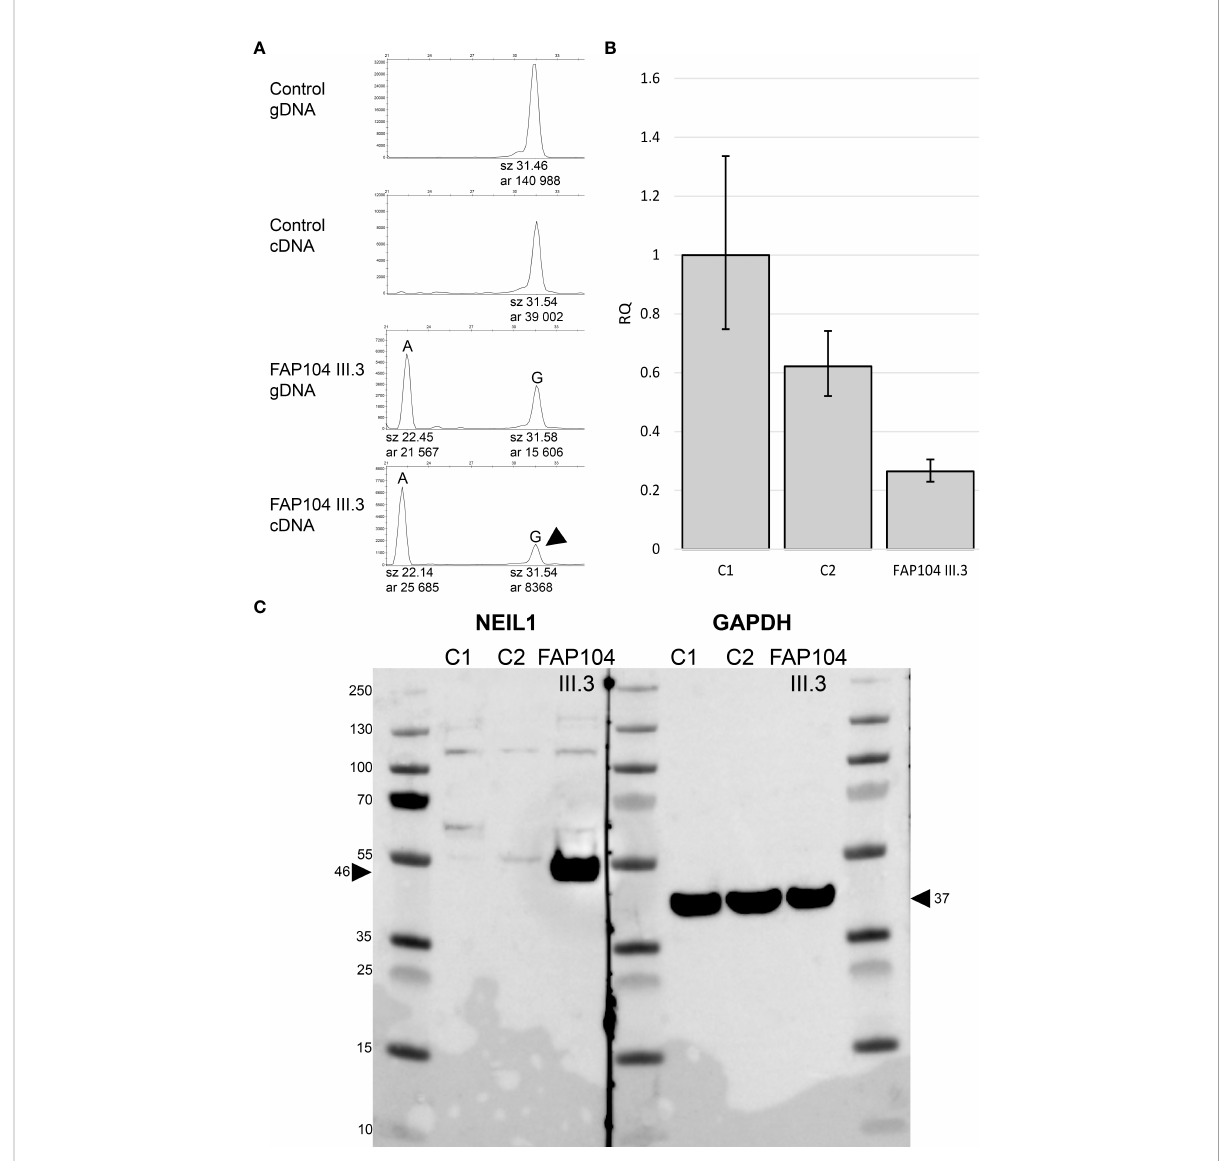
FIGURE 3 Expressional consequences of the NEIL1 c.506G>A, p.(Gly169Asp) variant. (A) ASE analysis based on the NEIL1 c.506G>A variant. Longer peak (G) represents the wild type sequence. The control individual is homozygous for the wild-type allele. The index individual of FAP104 is heterozygous: Allele A corresponds to the NEIL1 c.506A missense variant, whereas the G allele is known to have a frameshift variant (c.821delT) in a downstream position. This individual displays ASE with the peak area ratio of 0.45 for G to A in cDNA relative to gDNA. The result indicates that transcripts with G (arrowhead) having the frameshift variant are twice less abundant than transcripts containing the missense variant (A) . (B) Relative quantity (RQ) from the qRT-PCR experiment targeting the two main isoforms of NEIL1 using the housekeeping gene GAPDH as an endogenous control. Whiskers indicate 95% con fi dence limits. The index of family FAP104 shows reduced NEIL1 RNA expression compared to the controls. (C) Western blot of two healthy control individuals and the index of FAP104. GAPDH was used as a loading control. FAP104 index displays elevated NEIL1 protein levels compared to the controls (arrowhead). No truncated NEIL1 protein is